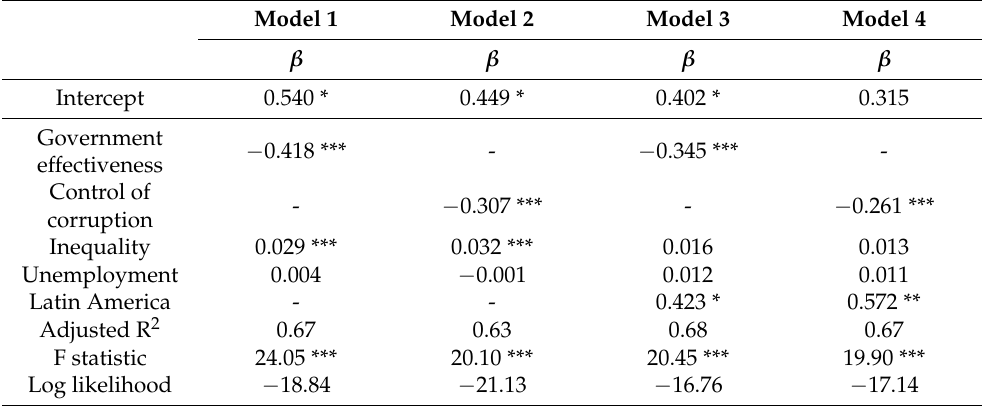
Table 3. Regression analysis results for homicide, government effectiveness, controls for